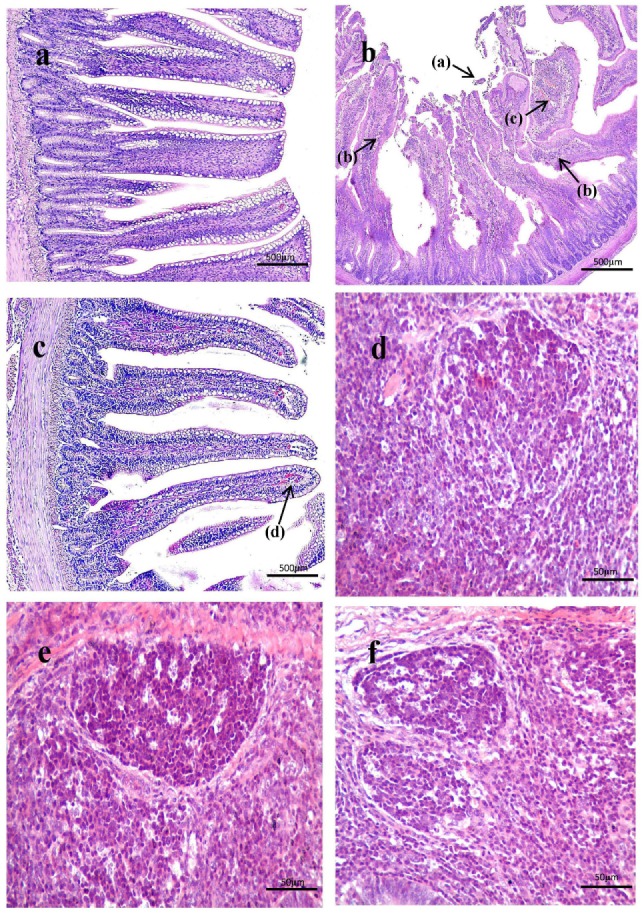
(A–C) Histological observation of ileum under original magnification (×40). (A) Ileum in the control group; (B) ileum in subclinical necrotic enteritis (SNE) group; (C) ileum in BS15 group; (D–F) histological observation of cecal tonsil under original magnification (×400); (D) cecal tonsil in the control group; (E) cecal tonsil in SNE group; (F) cecal tonsil in BS15 group. (1) Villi structure in the SNE group was destroyed and mainly presented the following features: shed epithelial cells (a), increased number of lymphocytes (b), and congested lamina propria (c). (2) In the BS15 group, lamina propriae were lightly congested (d). (3) No remarkable differences were observed in the cecal tonsil among the three groups.